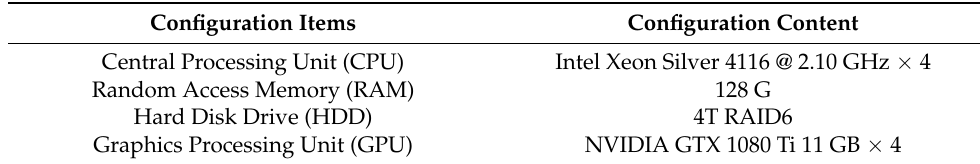
Table 2. The configuration of the experimental platform.